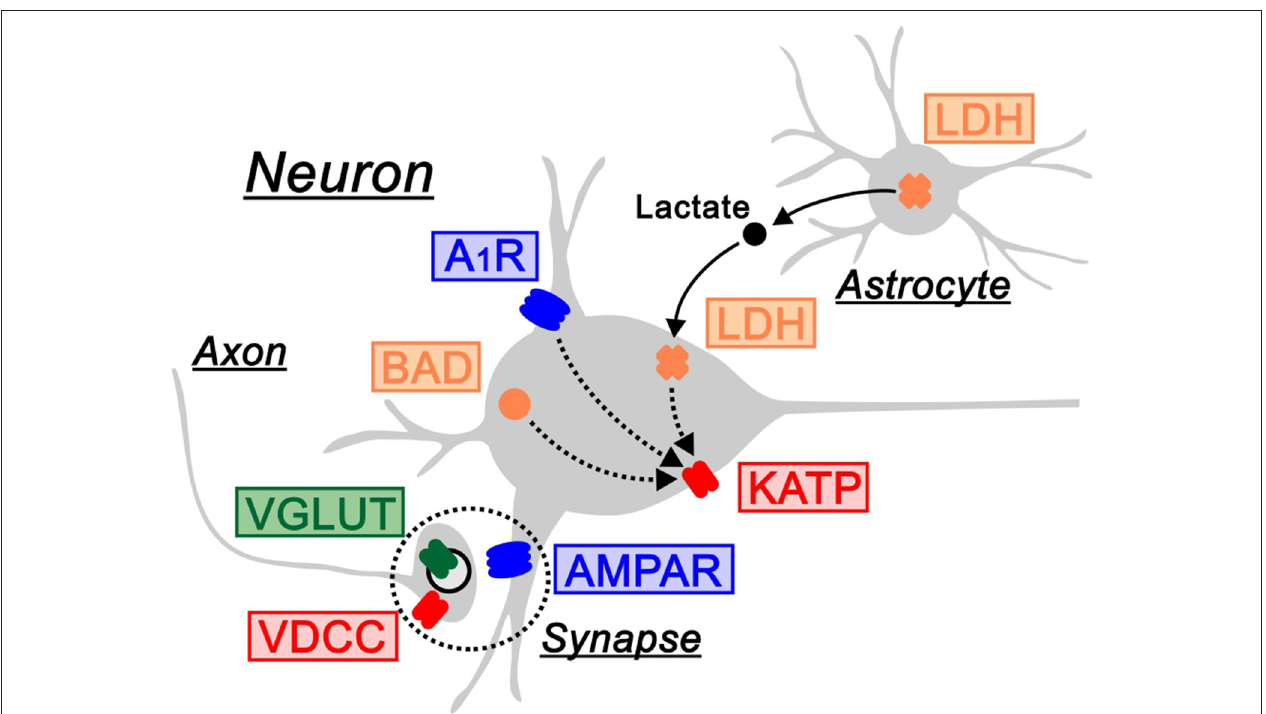
FIGURE 1 | Electrical regulators driven by the ketogenic diet. The ketogenic diet is associated with the following molecules that regulate electrical activities in neurons: ATP-sensitive K + channels (KATP) and voltage-dependent Ca 2 + channels (VDCC) as ion channels in red , AMPA-type glutamate receptors (AMPAR) and adenosine A 1 receptors (A 1 R) as synaptic receptors in blue , vesicular glutamate transporters (VGLUT) as neurotransmitter transporters in green , and BCL-2-associated agonist of cell death (BAD) and lactate dehydrogenase (LDH) as other molecules in orange . LDH is located in the astrocyte-neuron lactate shuttle (arrows). A 1 R, BAD and LDH regulate electrical activities via K ATP channels (dotted arrows). Synapse is indicated by dotted circles.